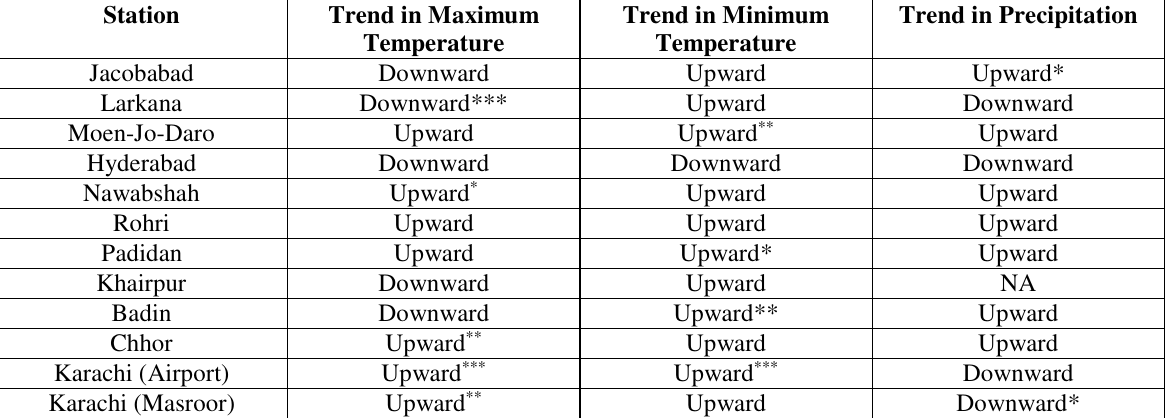
Table 1: Trend in temperature and precipitation at various meteorological stations of